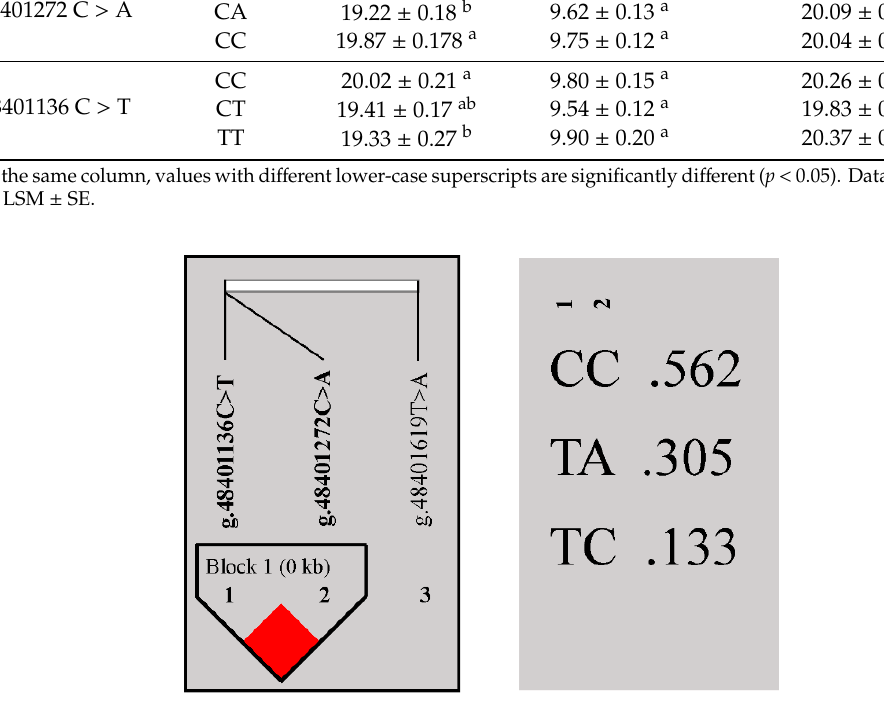
Figure 2. Linkage disequilibrium analysis of the BMP2 gene.